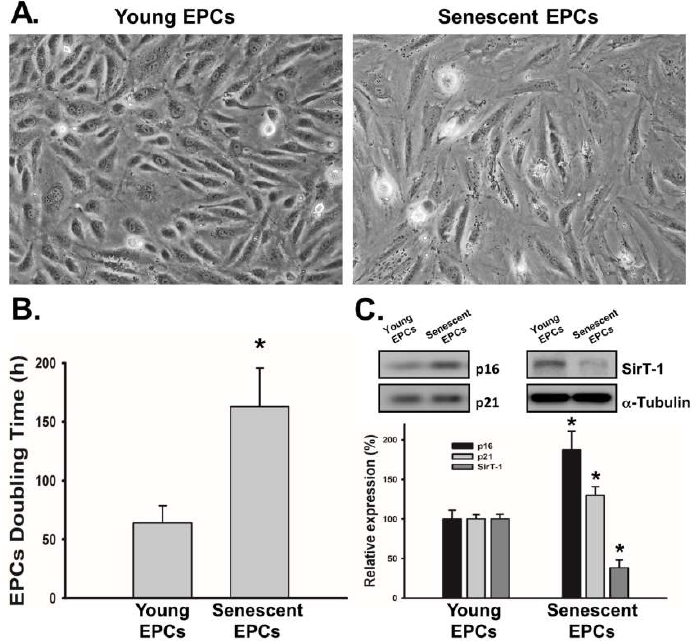
Figure 1. Senescence of endothelial progenitor cells (EPCs) was induced by serial passages. To obtain young and senescent EPCs, cells were grown in culture medium and serially passaged until their passage difference results in doubled cell doubling time. ( A ) The representative morphology of young and senescent EPCs was shown (phase contrast, 100×); ( B ) Cell doubling time was increased at least 2-fold in senescent EPCs after serial passages ( N = 6); ( C ) For characterization of senescence in EPCs, the expression of senescence marker p16, p21 and sirtuin 1 (SirT-1) was determined by Western blot analysis ( N = 6). Data are expressed as mean ± S.E.M. of six independent experiments. * p < 0.05 compared with the group of young EPCs.